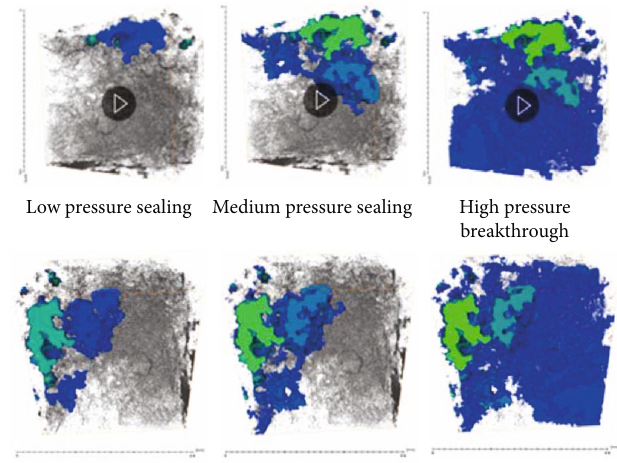
Figure 17: Simulation results of the fi xed digital core model with changed boundary